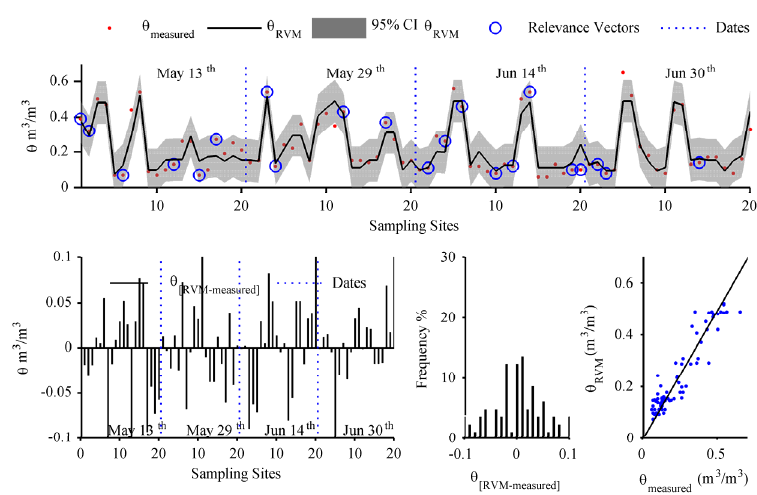
Figure 6. Performance of the soil moisture RVM model, including the 95% confidence interval (CI) using the bubble kernel using all available data: (top) measured vs. RVM soil moisture values, (lower left) residual distribution, (lower center), residual histogram and (lower right) 1:1 measured vs. RVM surface soil moisture plot.